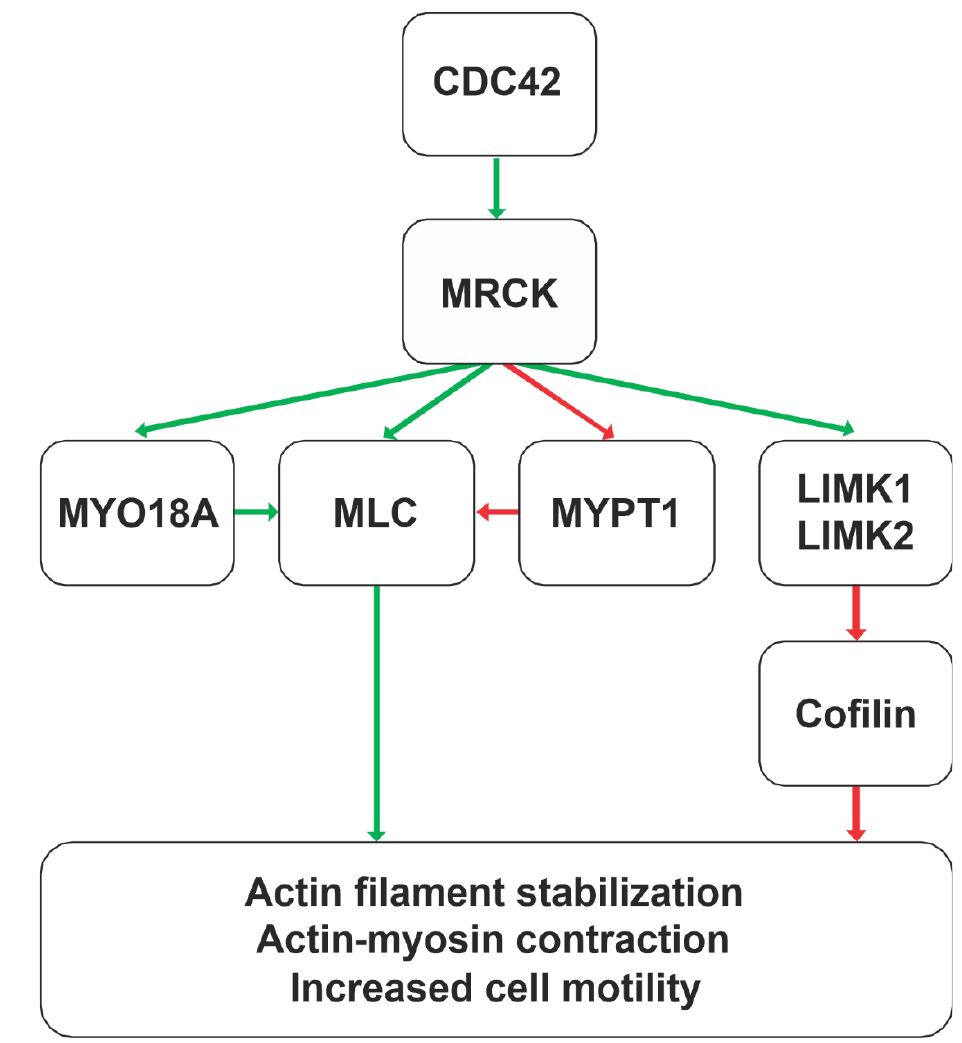
Figure 3. MRCK signalling pathways leading to actin – myosin cytoskeleton regulation . Acting downstream of the Cdc42 GTPase, the MRCK kinases MRCKα, MRCKβ, and MRCKγ phosphorylate substrates that ultimately lead to the stabilization of actin filaments and promotion of actin – myosin contractile force generation. These actions on the actin – myosin cytoskeleton contribute to increased cell motility.